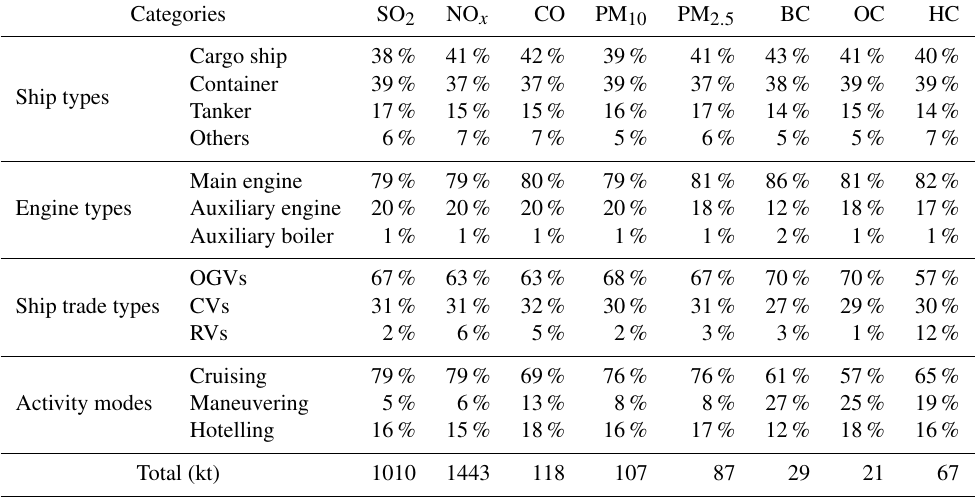
Table 8. Summary of ship emissions in China (within 200Nm of the coast) in 2013.